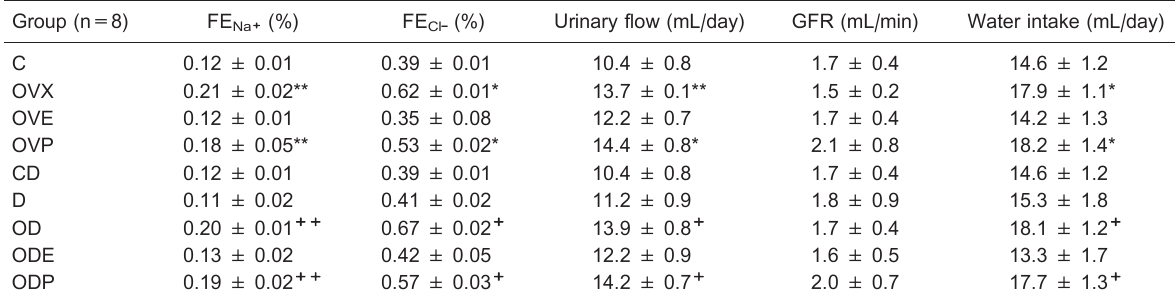
Data are reported as means±SE (n=8 per group). See Table 1 legend for explanation of groups. *P , 0.05 and **P , 0.01 compared to C; + P , 0.05 and ++ P , 0.01 compared to CD (ANOVA and Tukey